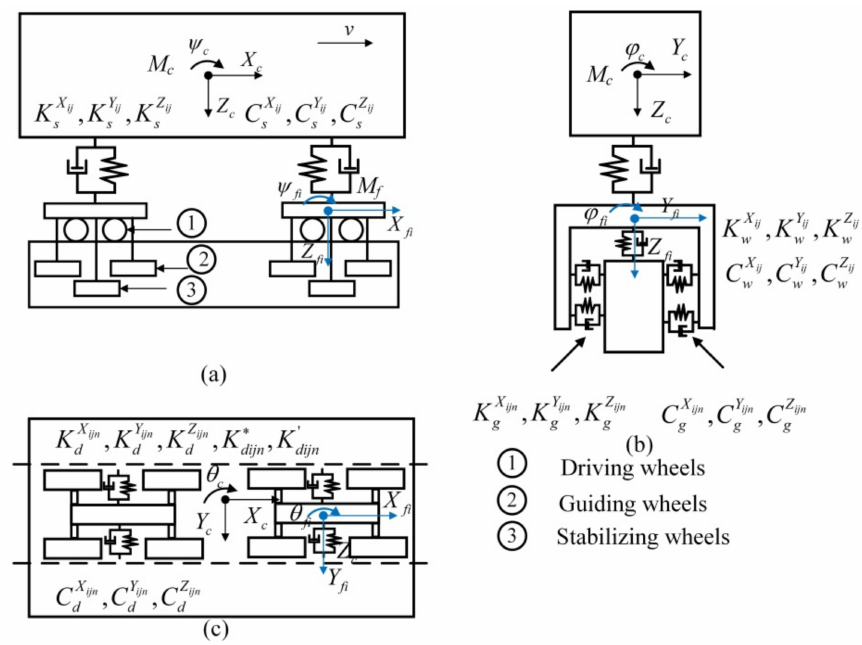
Figure 3. Dynamic model of vehicle subsystem: ( a ) right view; ( b ) front view; ( c ) top view. where i = 1, 2 indicates the positions of the front and rear bogies; j = 1, 2 indicates the positions of the left and right bogies; n = 1, 2 indicates the front and rear tires of the same